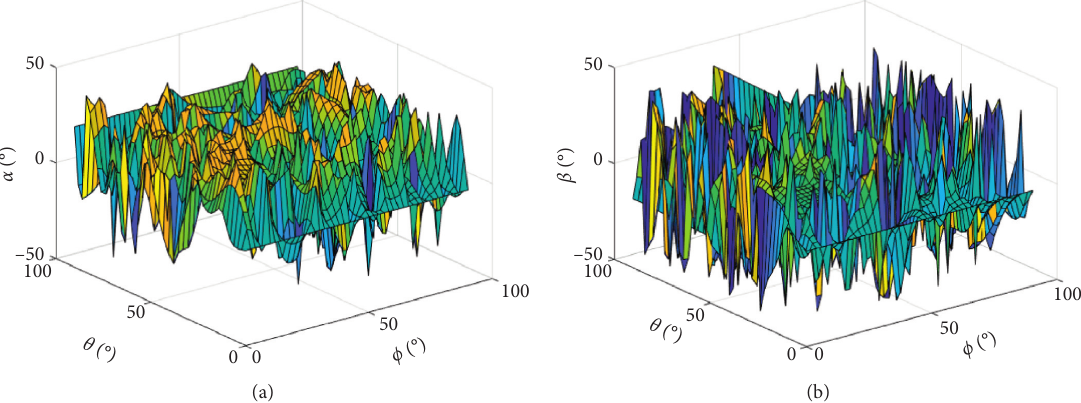
Figure 11: The surface of polarization parameter pair using the MODE. (a) Orientation angle. (b) Ellipse